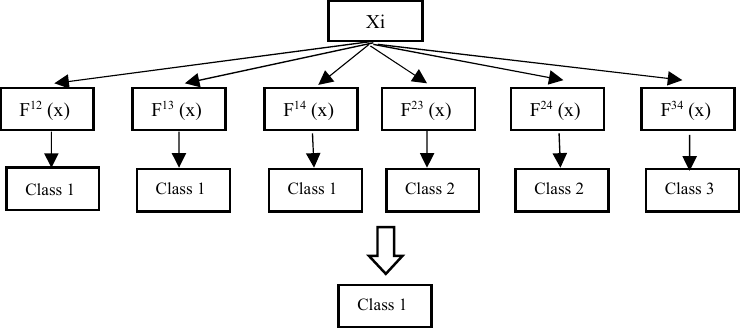
Fig. 2. Examples of classification with the SVM